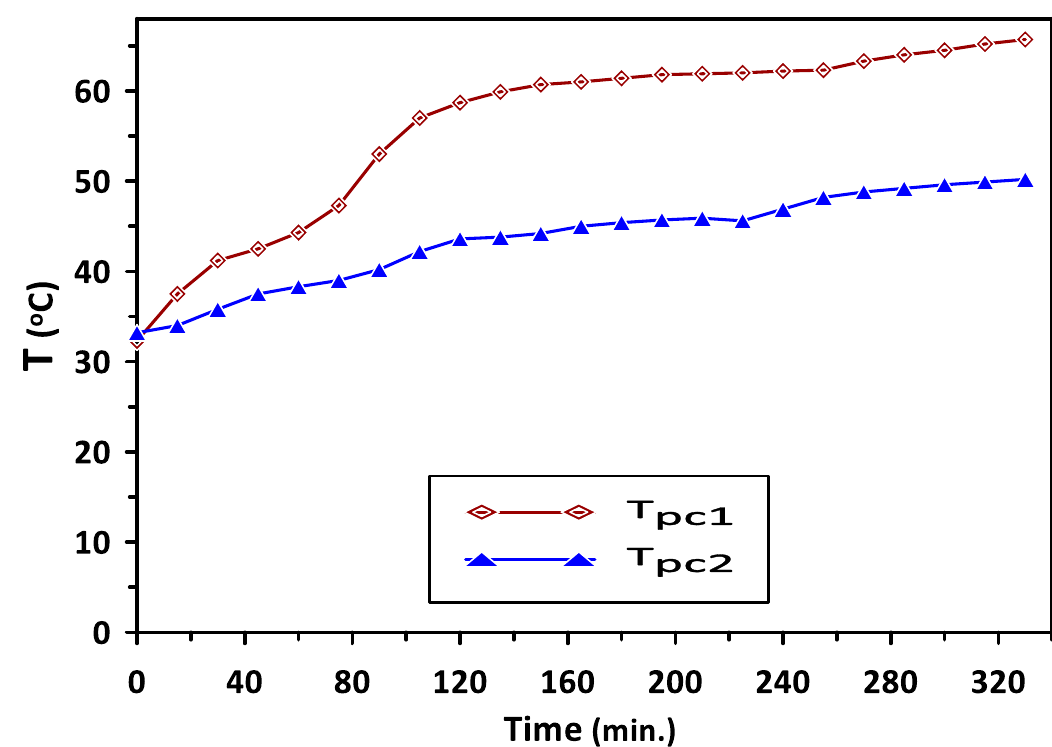
Figure 5. Variations in PCM1 and PCM2 temperatures with time during the charge cycle at duct inlet air temperature of 65 °C.